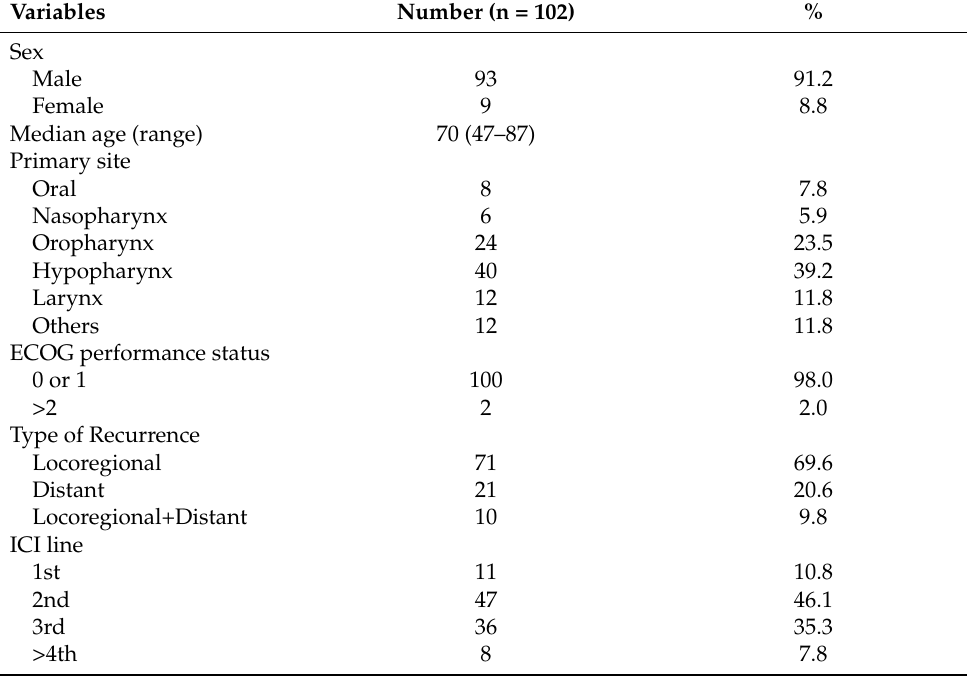
Table 1. Patient